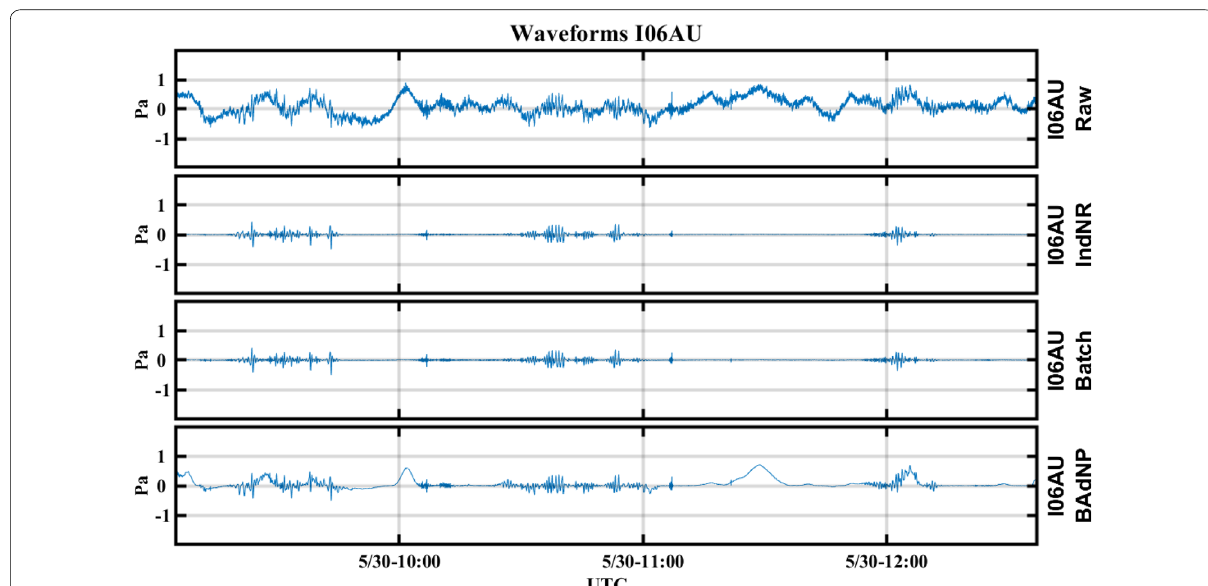
Fig. 5 Waveforms resulting from the analysis presented as a spectrogram in Fig. 1. In the process of converting the waveform from an infrasound signal sampled at 20 Hz into a file readable by the software, the amplitude was normalized. For this plot the output of Izotope RX noise